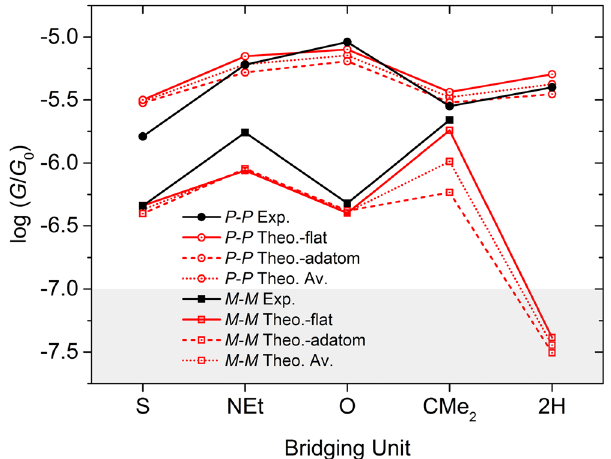
Figure 8. Comparison between theoretical and experimental data for most probable conductance values. DFT results are shown for both flat electrodes (solid red lines) and with electrodes containing adatoms (dashed red lines). The dotted lines show the average of the ‘flat’ and ‘adatom’ DFT conductances. Although there are differences, we conclude that the same qualitative trends are obtained using both geometries, with the exception of CMe 2 , which in the presence of adatoms, no longer has an anomalously high conductance observed experimentally in the meta case 9-C m